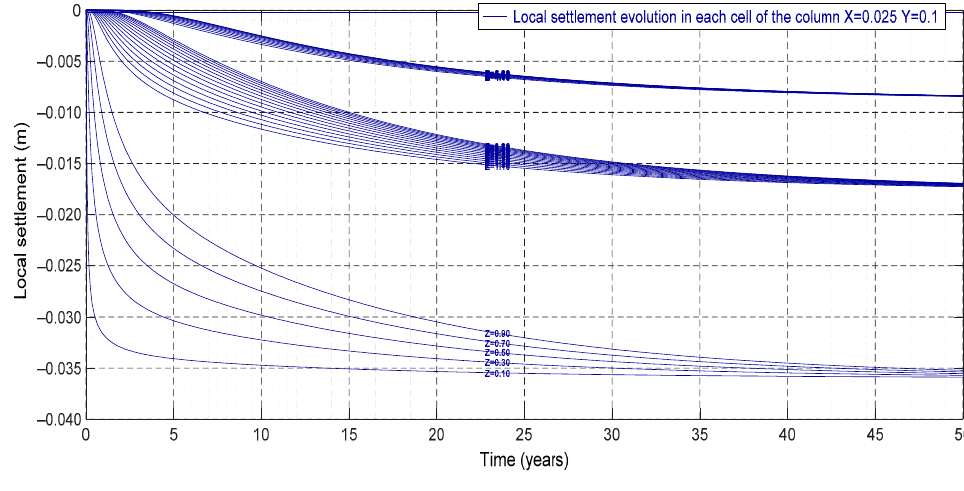
Figure 17. Local settlements evolution for the case with no PVDs (N z = 30).